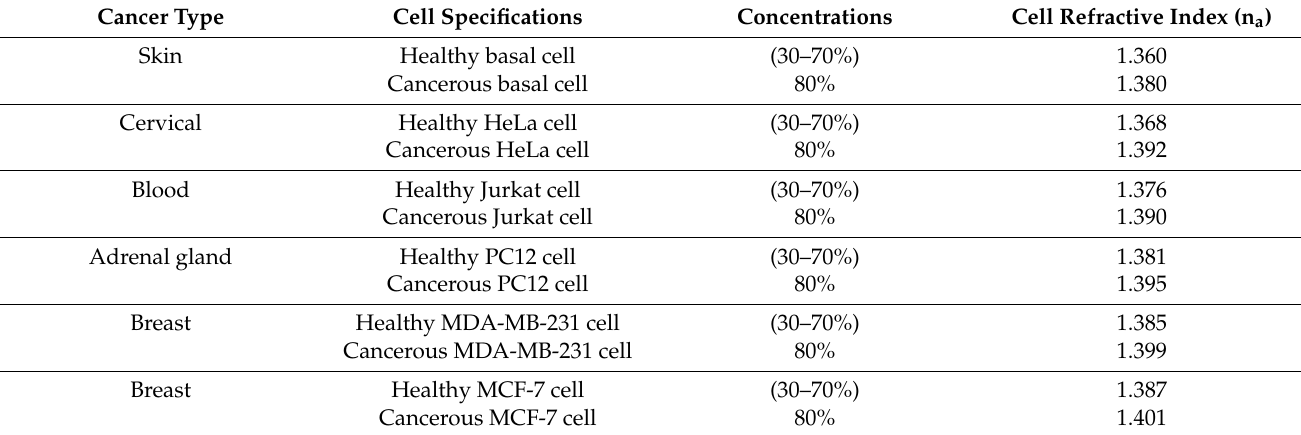
Table 2. Normal and cancerous cell analyte refractive index